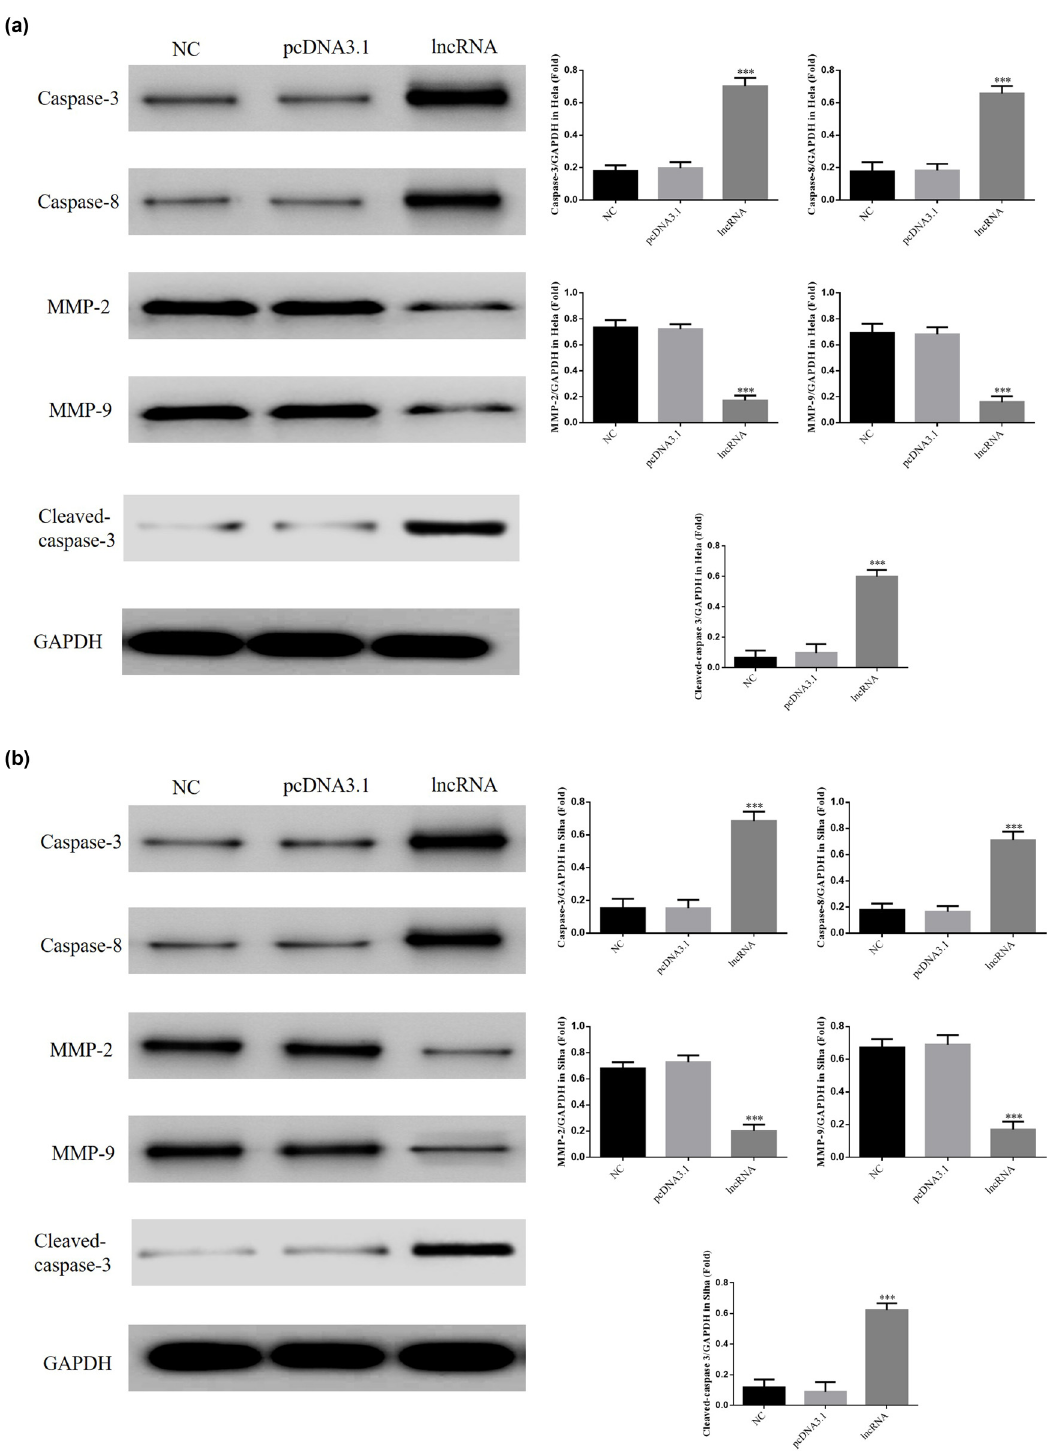
Figure 6: UBE2R2 - AS1 a ff ected relative proteins expressions by WB assay. NC: normal control group; pcDNA 3.1: the cells were transfected with pcDNA3.1; lncRNA: the cells were transfected with UBE2R2 - AS1 by pcDNA3.1. ( a ) UBE2R2 - AS1 a ff ected relative proteins expressions by WB assay in HeLa cell. *** P < 0.001, compared with NC group. ( b ) UBE2R2 - AS1 a ff ected relative proteins expressions by WB assay in SiHa cell. *** P < 0.001, compared with NC